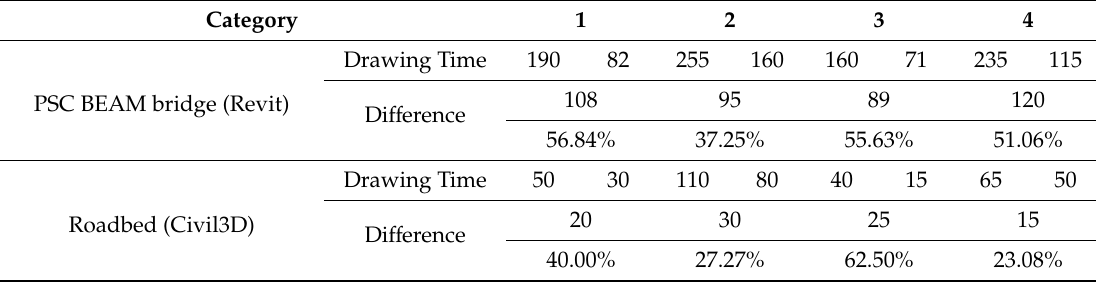
Table 8. Result of